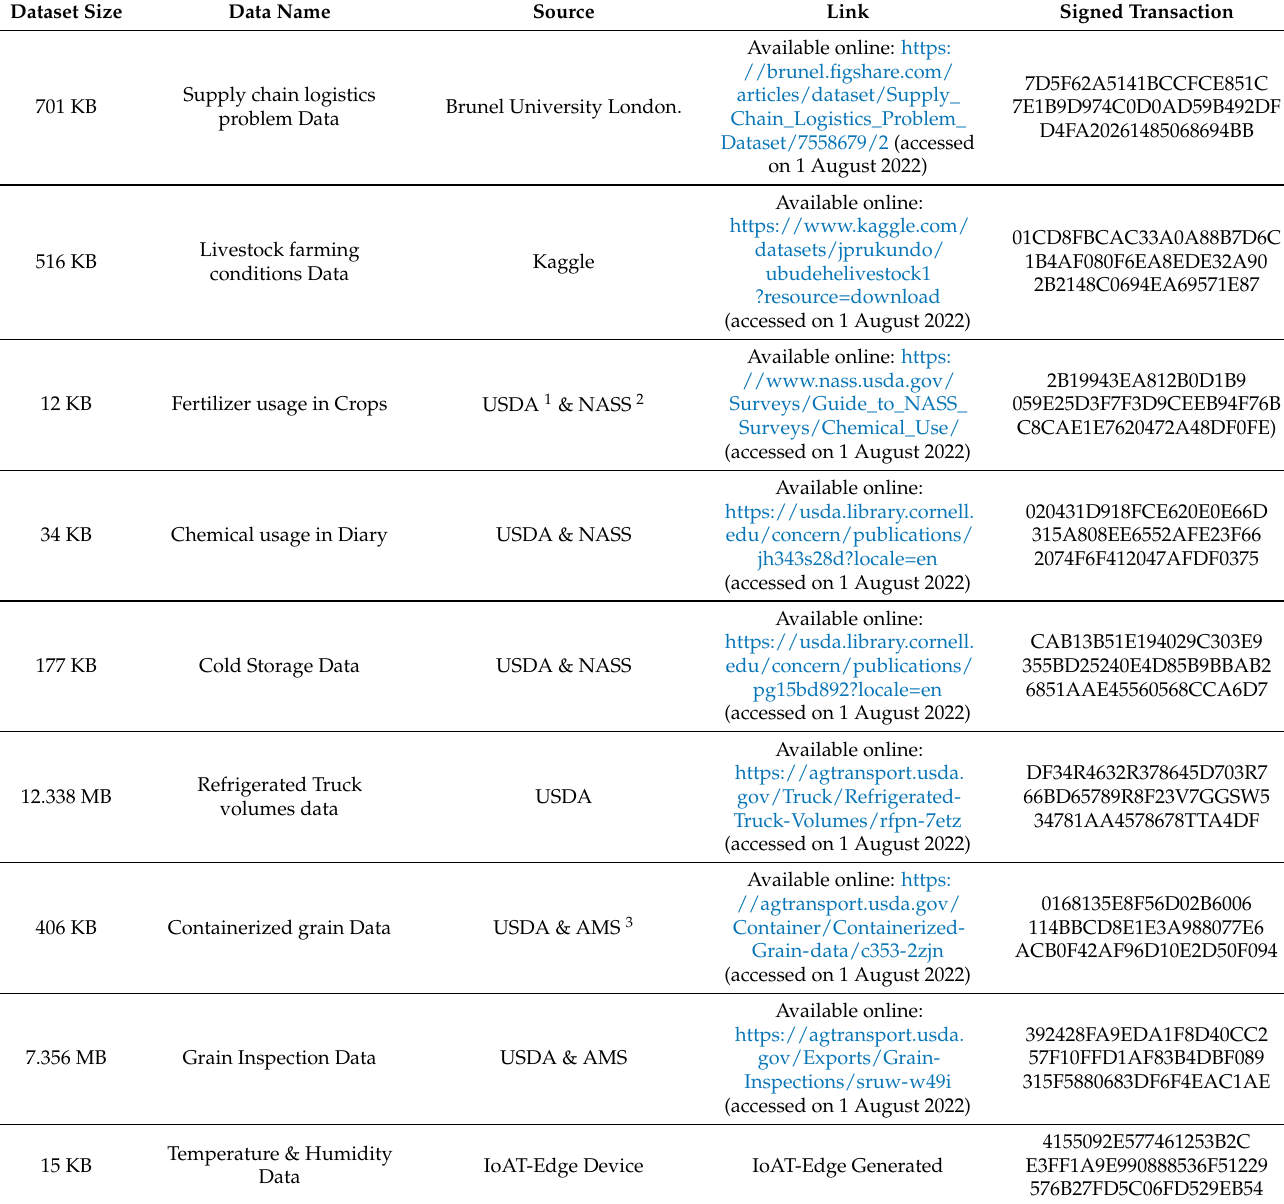
Table 2. Datasets for